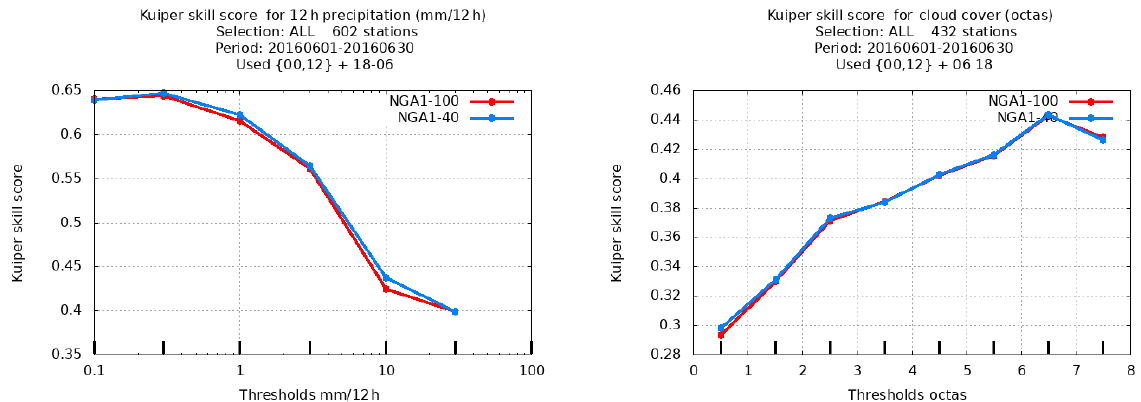
Figure 10. Kuiper skill score for 12h accumulated precipitation (left) and + 6 and + 18h cloud forecasts (right) for verification against SYNOP stations in the